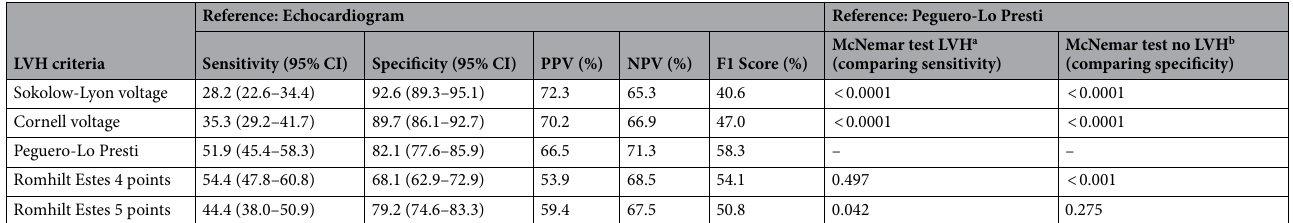
Table 2. Diagnostic performance of the ECG criteria. Comparison of the performance of the ECG criteria a McNemar test comparing other ECG criteria versus Peguero-Lo Presti in patient with LVH in echocardiogram; b McNemar test comparing other ECG criteria versus Peguero-Lo Presti in patient without LVH in the echocardiogram; a and b = p < 0.05 indicates lack of agreement. CI confidence interval; NPV negative predictive value; PPV positive predictive